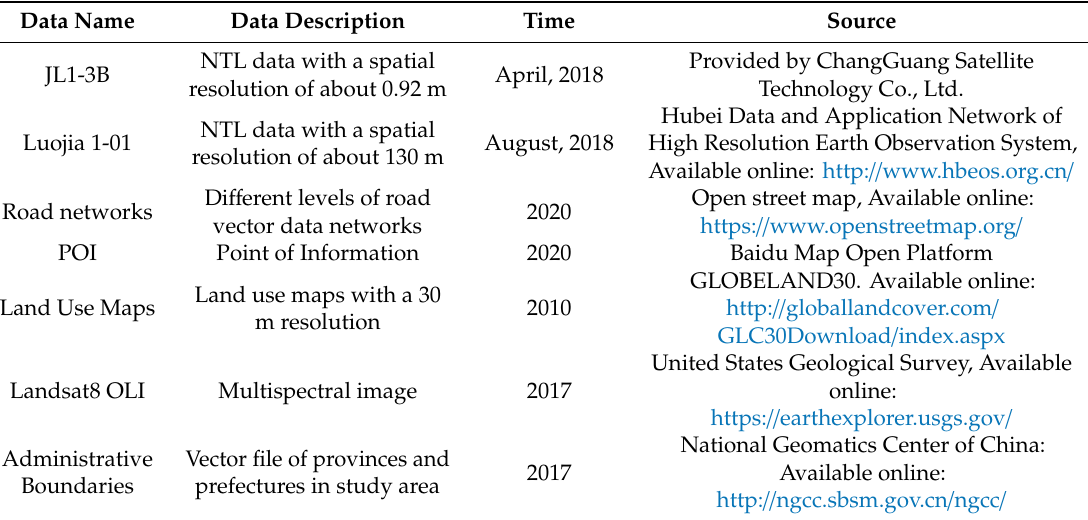
Table 2. Details of data used in this study.